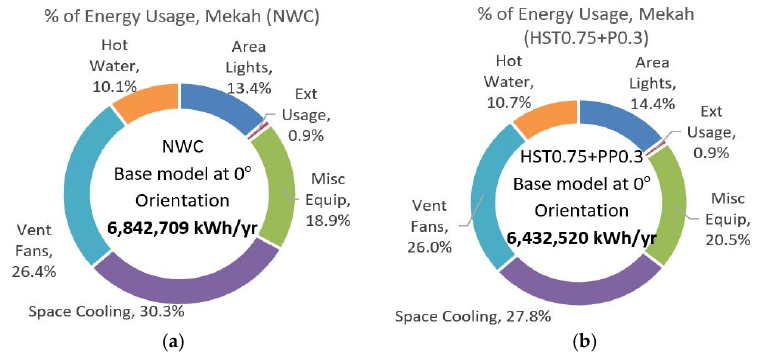
Figure 7. Percentage breakdown of annual energy consumption end-use comparison for Makkah: ( a ) NWC; ( b ) HST0.75 + PP0.3.